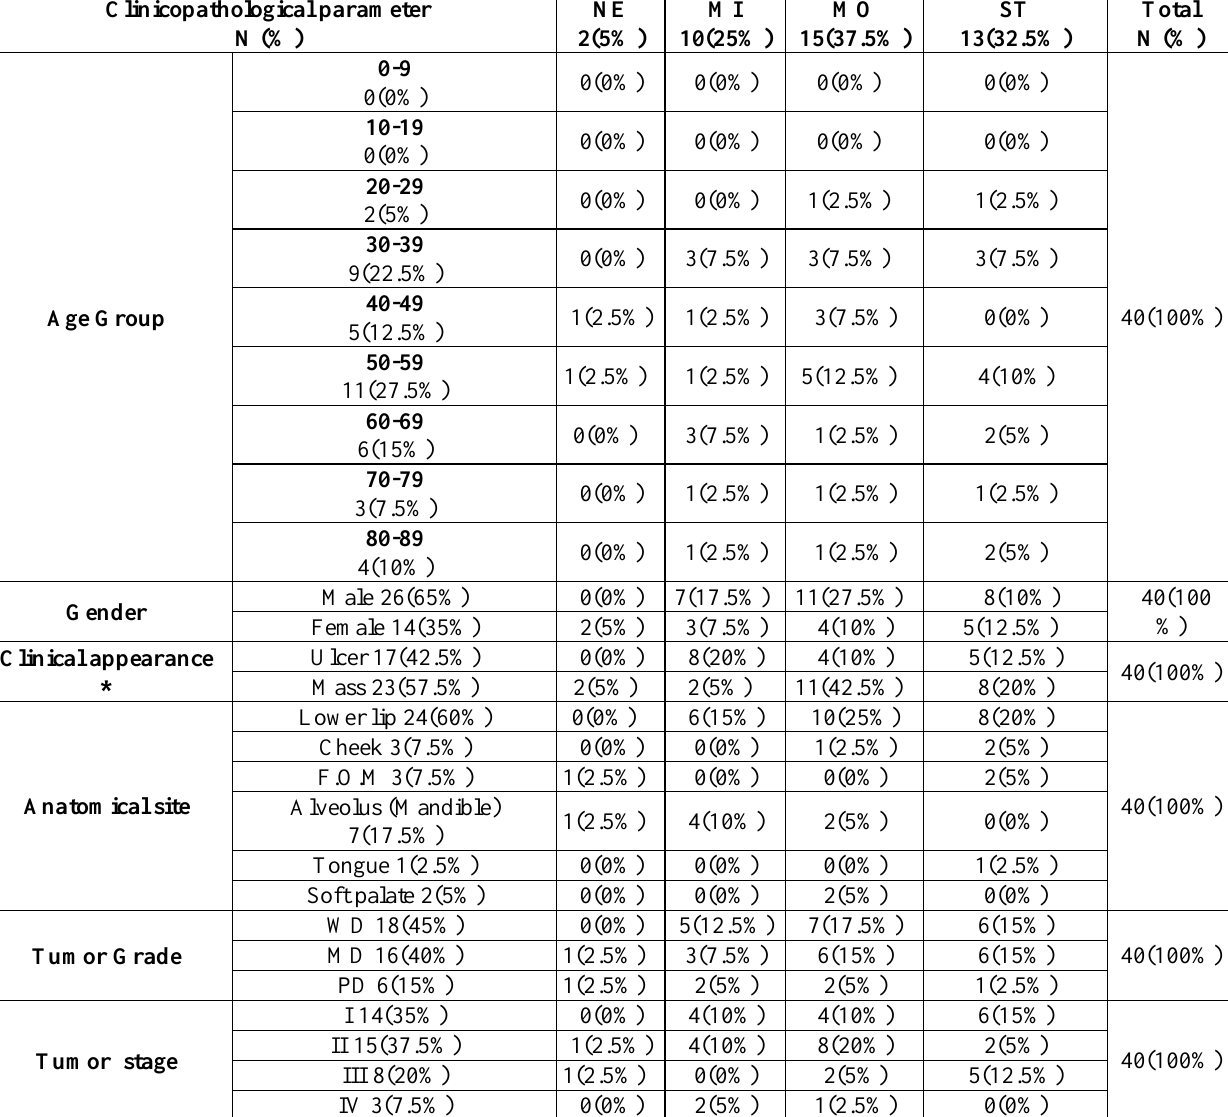
Table 2: Clinicopathological finding vs. Immunohistochemical expression of ATM Clinicopathological